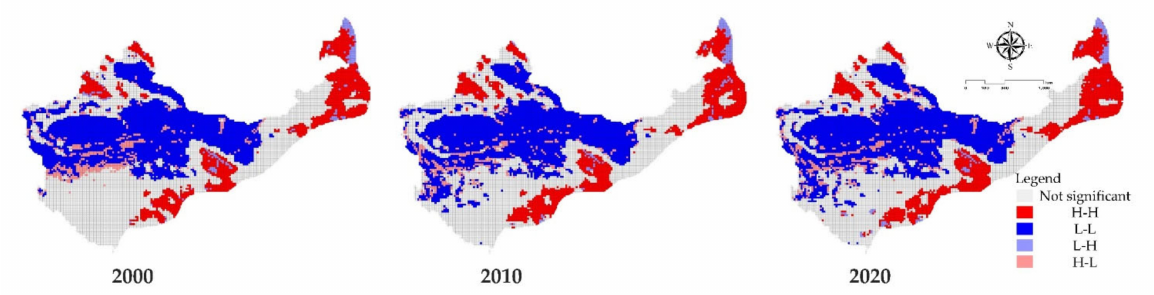
Figure 4. LISA cluster map of human footprint index and ecosystem service value space in the study area on a 20 km scale in 2000, 2010, and